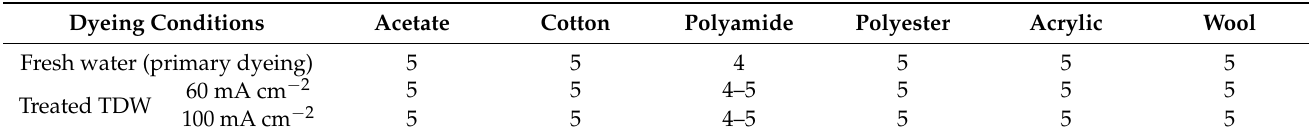
Table 8. Color fastness to washing of the wool fabrics dyed using fresh water (primary dyeing) and TDW after the second EO